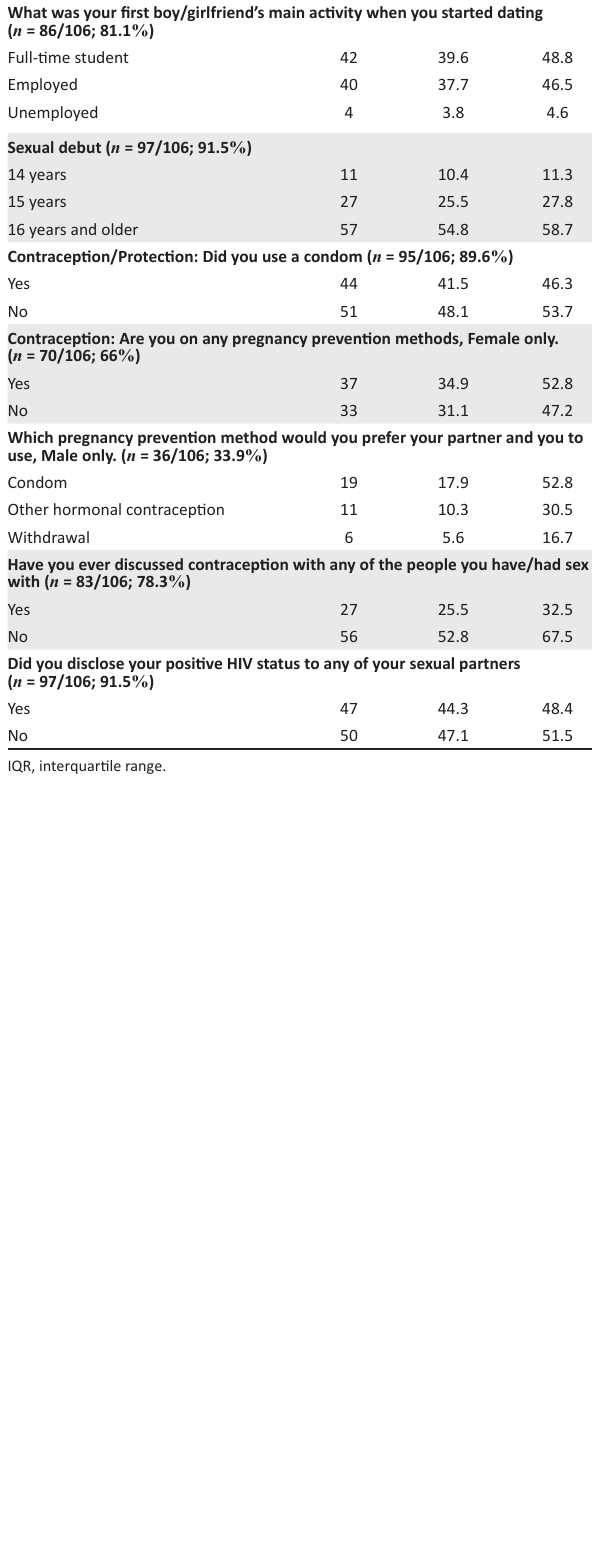
TABLE 1-A1 (Continues...): Responses to the interview questionnaire. Responses to the interview